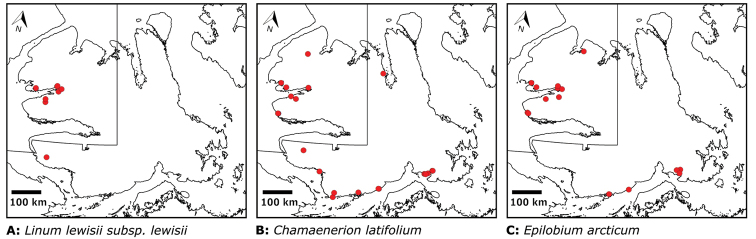
Species distribution maps. Linaceae: ALinum
lewisii
subsp.
lewisii. Onagraceae: BChamaenerion
latifoliumCEpilobium
arcticum.